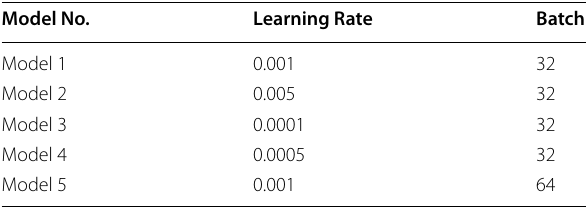
Table 1 Hyper-parameters of 5 models Model No.